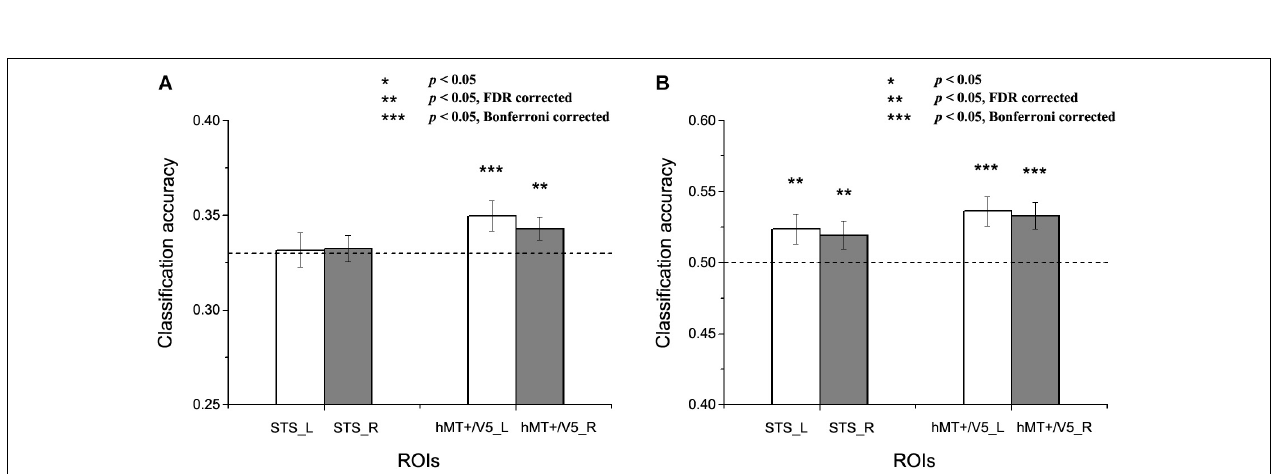
FIGURE 5 | Results of the cross-subject emotion decoding analysis. (A) Classification accuracies for three emotions, and (B) Classification accuracies for positive versus negative emotions. The dashed line indicates chance level, and all error bars reflect the SEM. Asterisks indicate statistical significance with a one-sample t -test, p < 0.05 [** p < 0.05 false discovery rate (FDR) corrected; *** p < 0.05 Bonferroni corrected].